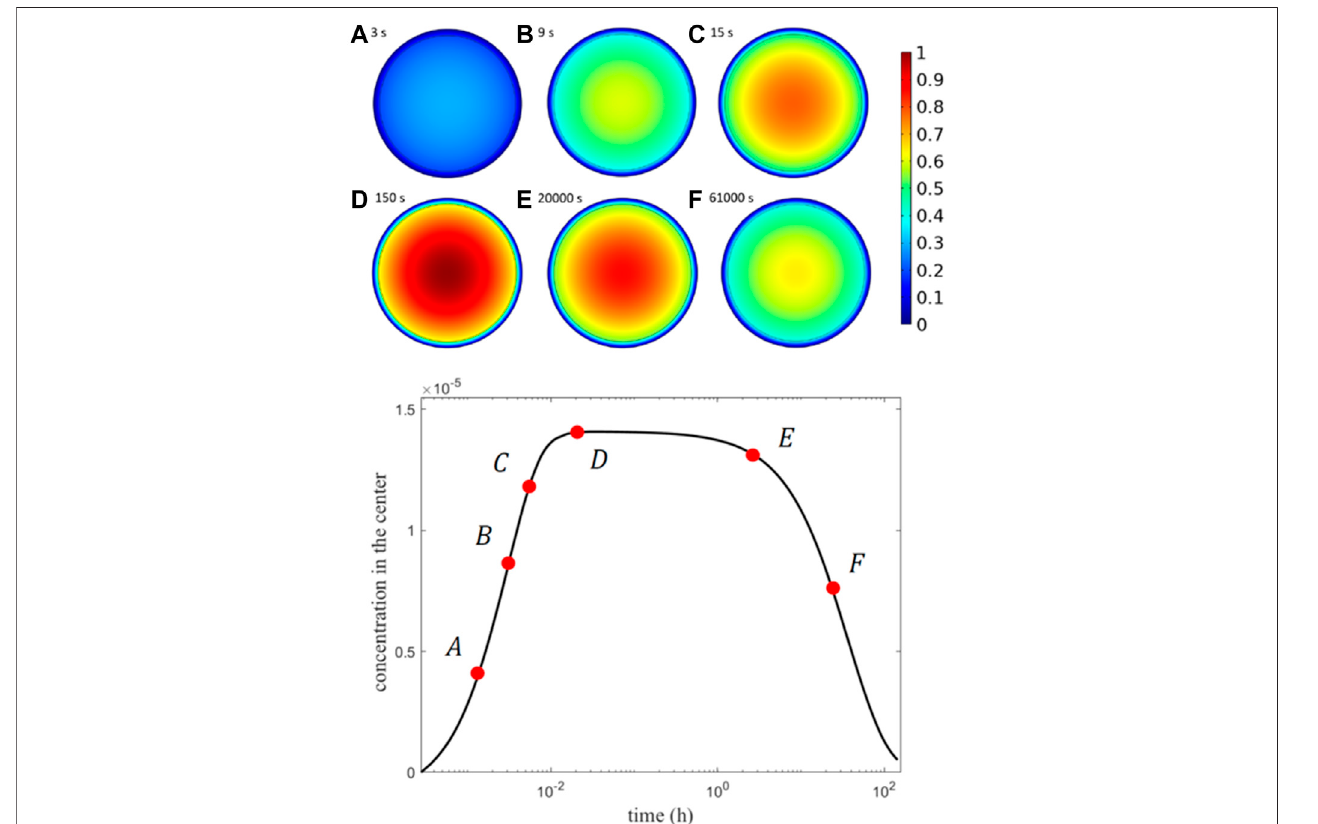
FIGURE6| Top:concentration fi eldatsixdifferenttimeslabelledfromA(after3 s)toF(after61000 s).Bottom:plotofthemaximumconcentrationattheMPcenter vs. time at the 6 selected times.